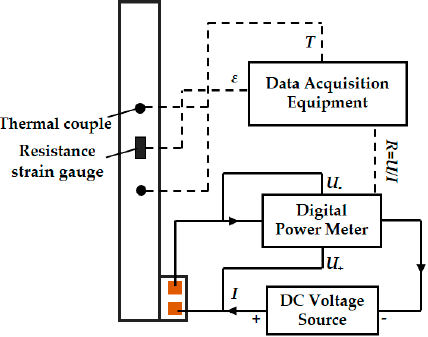
Figure 3. Schematic diagram for thermal cycling test.